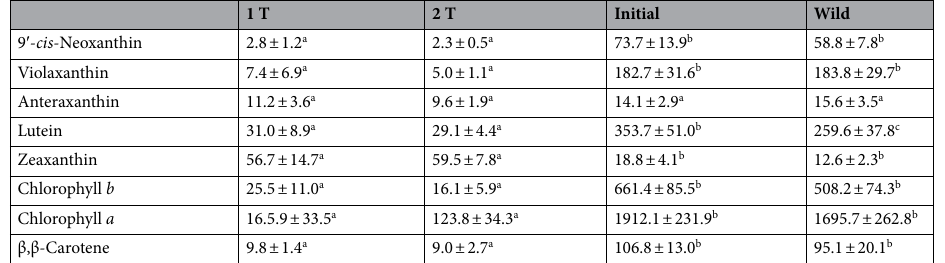
Table 5. Pigment concentrations (µg g −1 DW biomass) recorded in halophytes ( Salicornia ramosissima ) cultured cultured in the same tank (1 T) or in separate tanks (2 T) with polychaetes ( Arenicola marina — Amar—and Hediste diversicolor —Hdiv), as well as initially stocked plants and conspecifics from the wild. Average values ± SD (n = 5). Different letters indicate significant differences ( p < 0.05) between samples.